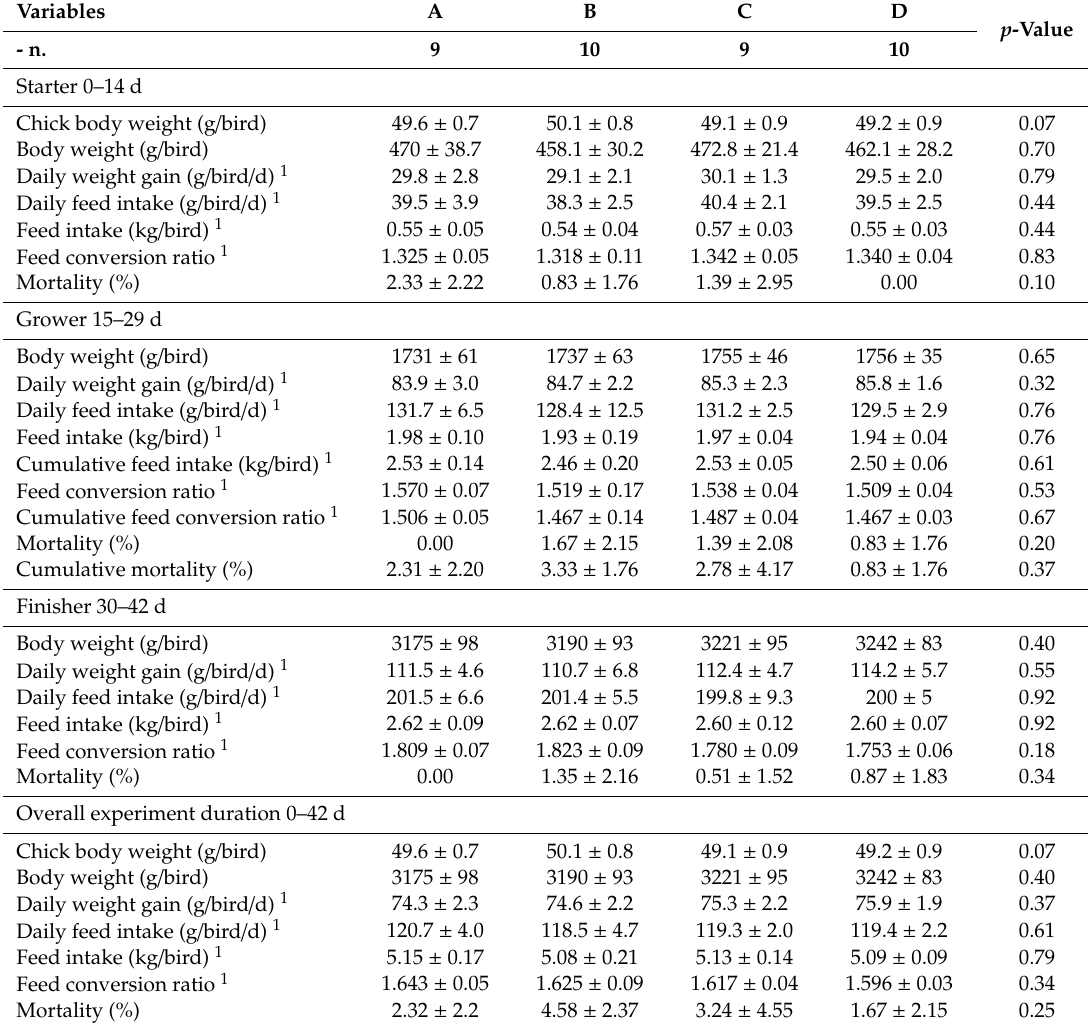
Table 2. Productive performance (mean ± SD) in each feeding phase and in the overall period of the trial